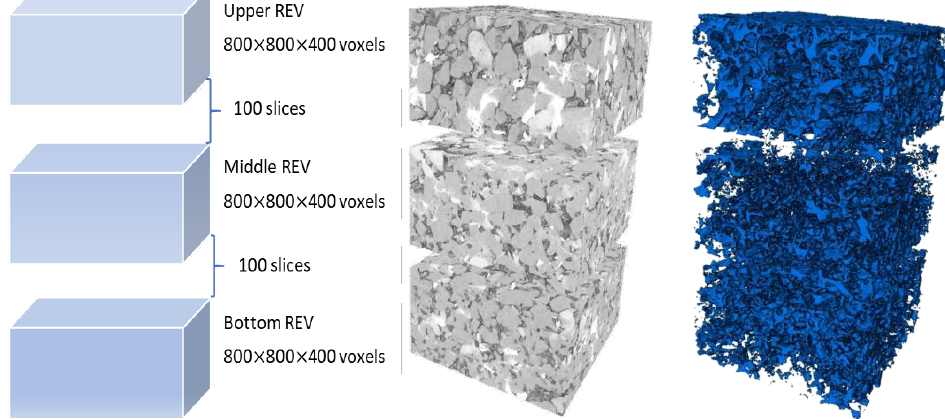
Figure 7. Schematic plot showing spatial position (left), gray-scale CT image (middle) and extracted pore space (right) of REVs characterizing upper, middle, and bottom subdomains of the whole-core domain.